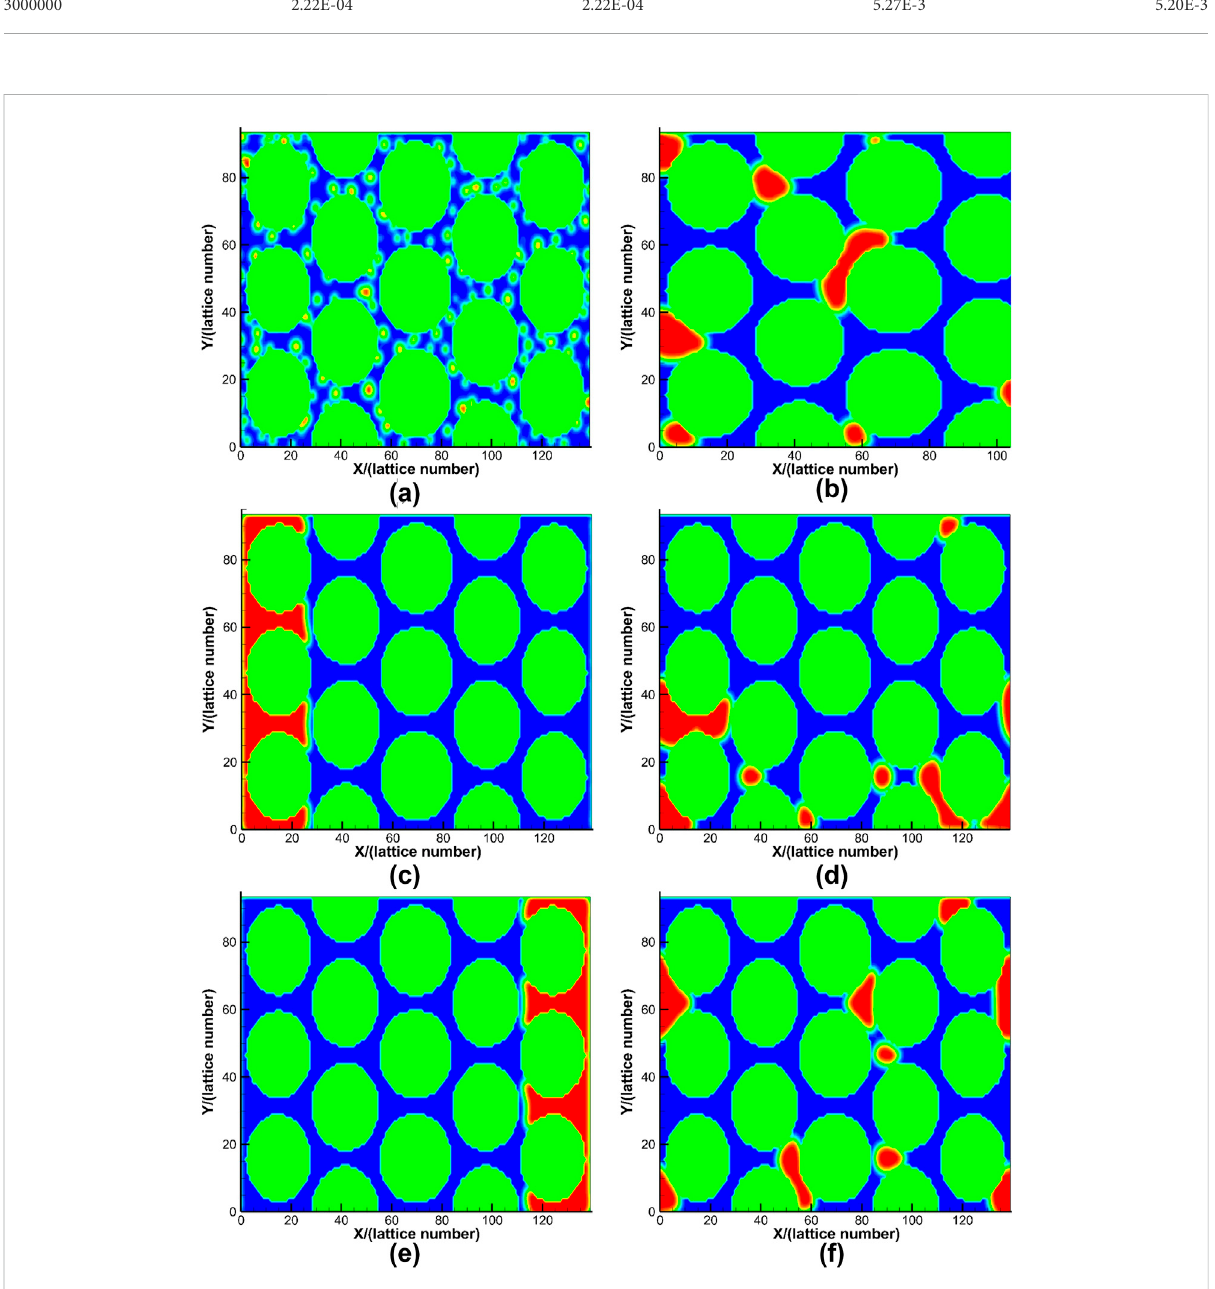
FIGURE 5 Thesimulationresultsofthreeinitialdistributions(redfordecane,andblueforwater): (A) Therandomdistributionattheinitialtimestep. (B) The random distribution at the last time step. (C) The upstream distribution at the initial time step. (D) The upstream distribution at the last time step. (E) The downstream distribution at the initial time step. (F) The downstream distribution at the last time